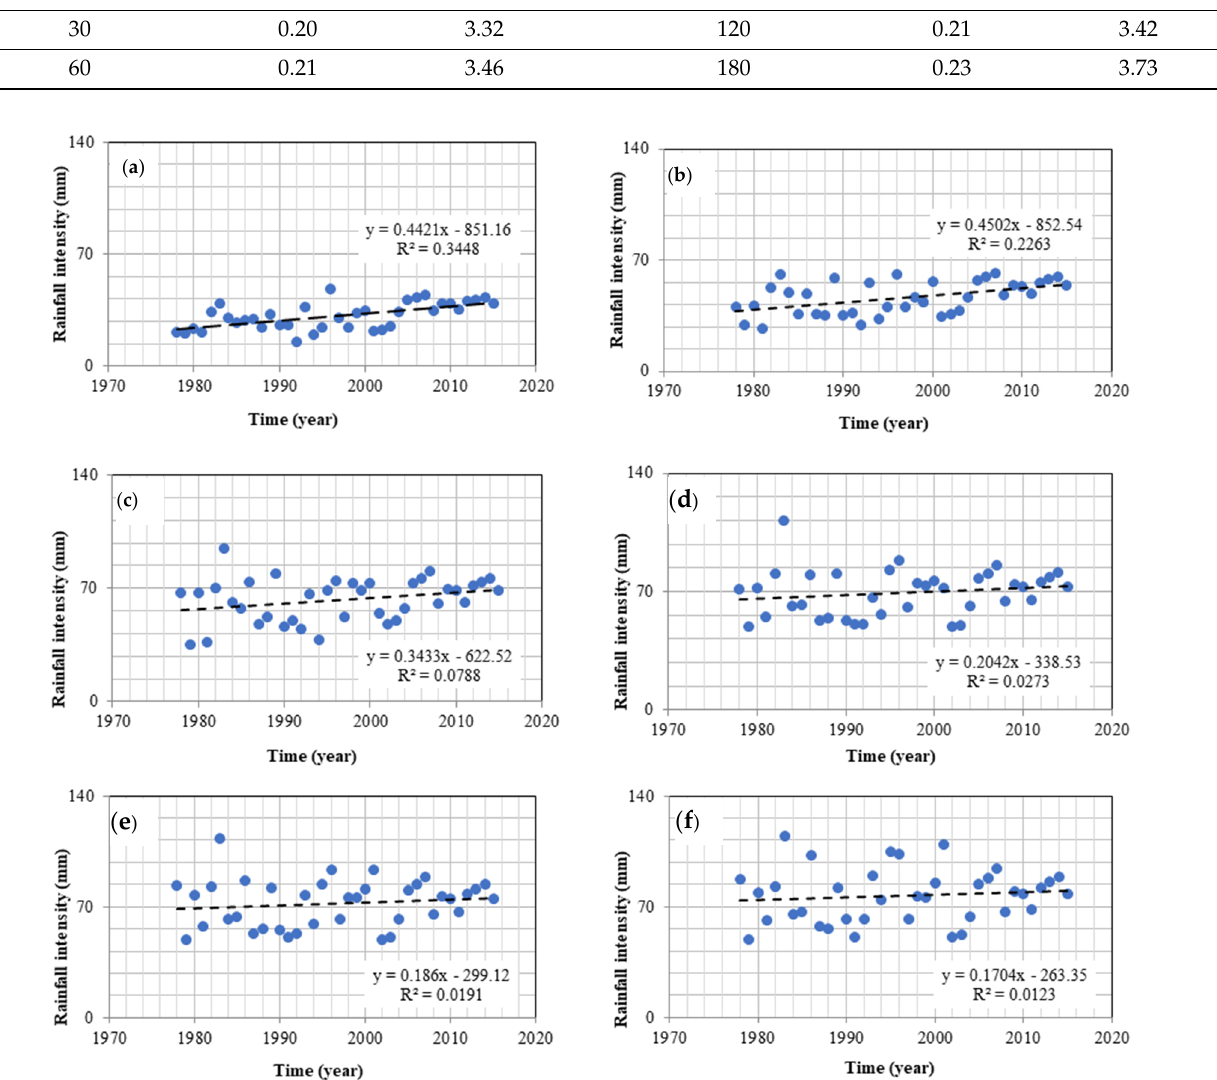
Figure 5. The trend of maximum rainfall for 15 min ( a ), 30 min ( b ), 60 min ( c ), 90 min ( d ), 120 min ( e ), 180 min ( f ) periods, respectively. Table 1. Coefficient of variation and average relative error of maximum rainfall over each period at Can Tho station.